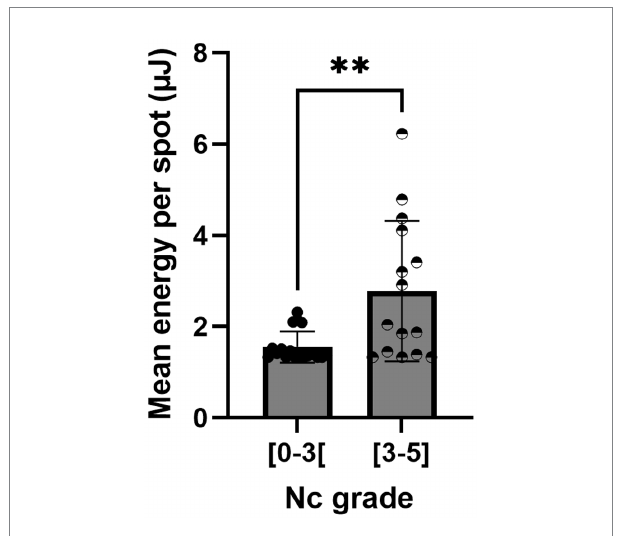
FIGURE 4 Mean energy sent per spot according to the nuclear color cataract grade.